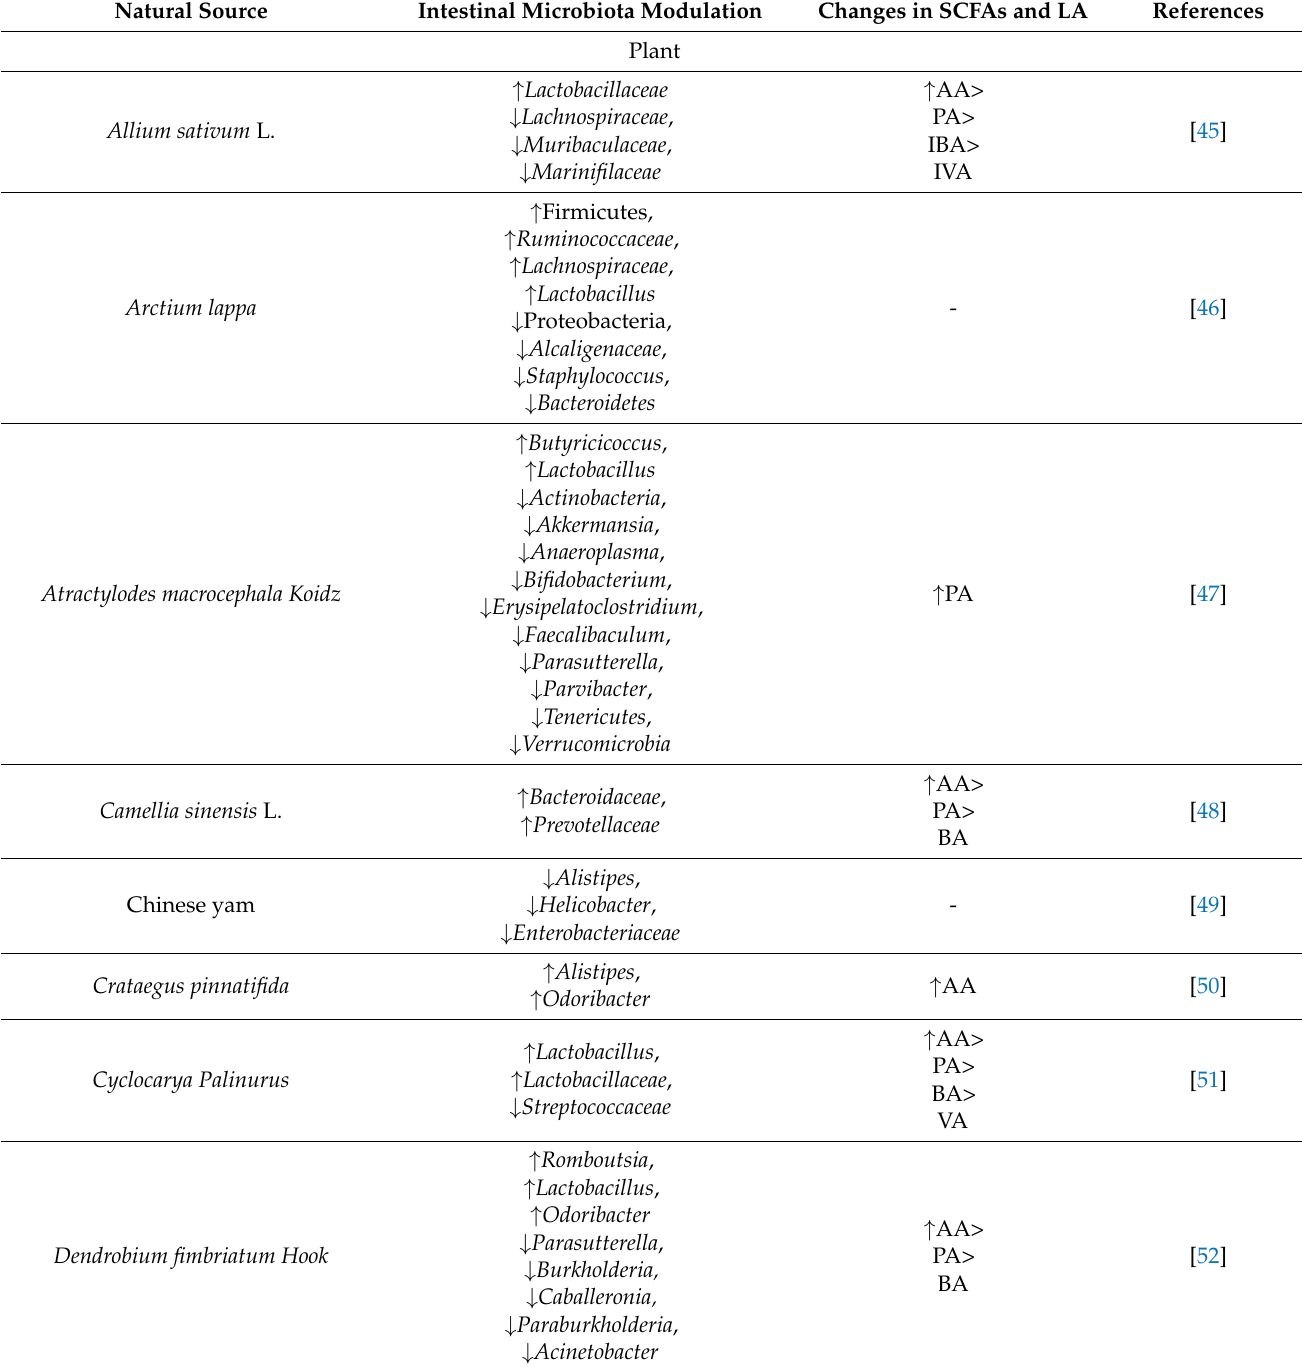
Table 1. Effects of natural polysaccharides on intestinal microbiota modulation in inflammatory bowel disease (IBD)